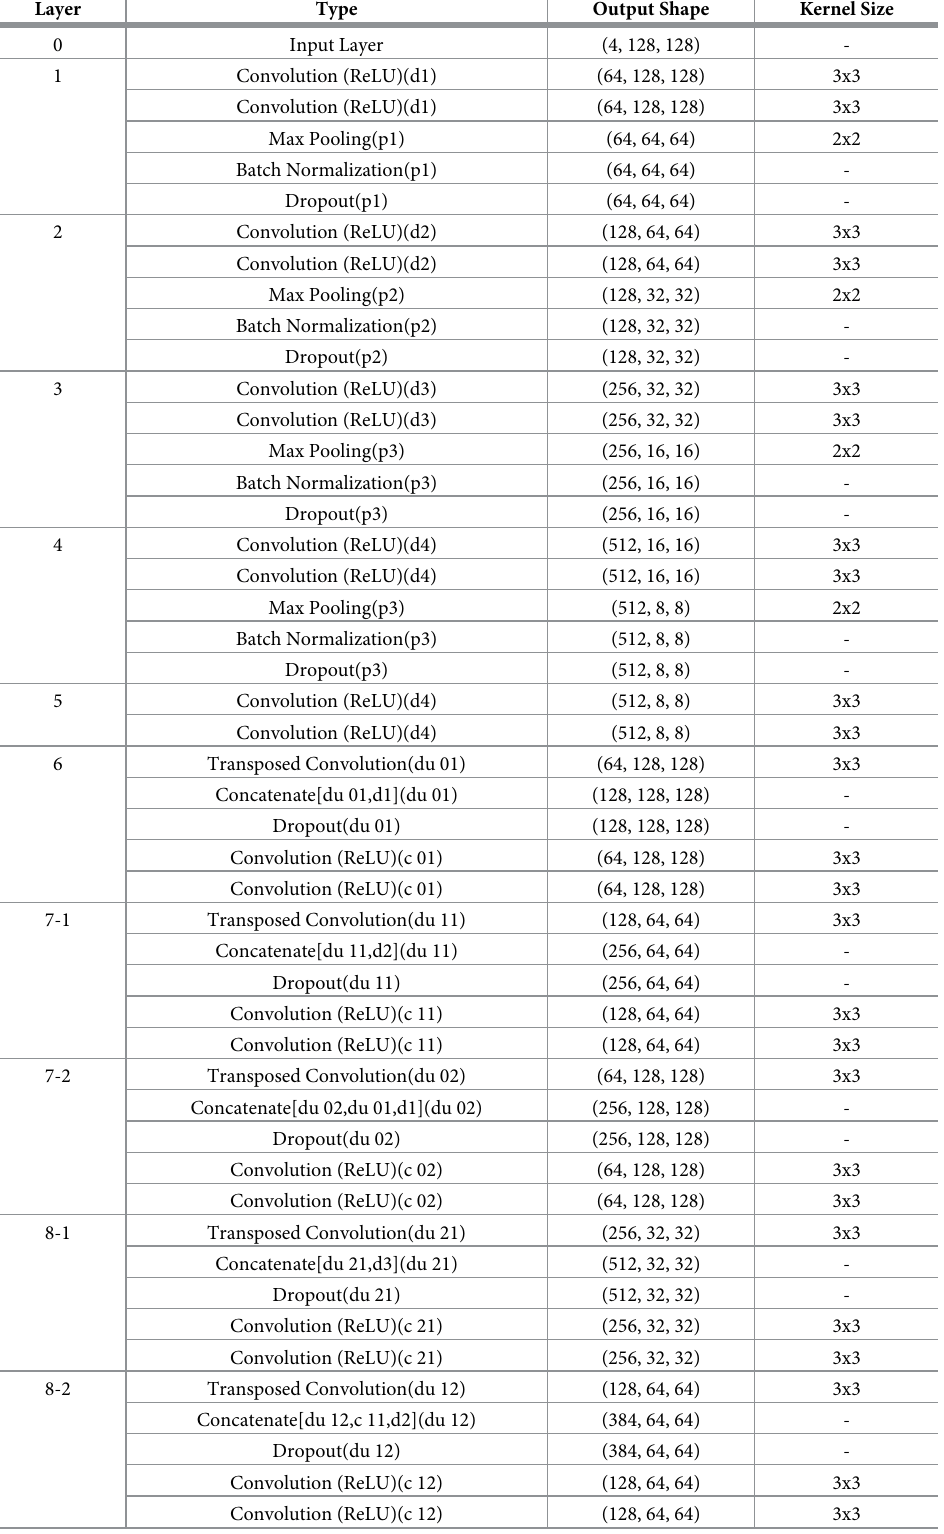
Table 7. 3D U-Net++ model structure for tumor